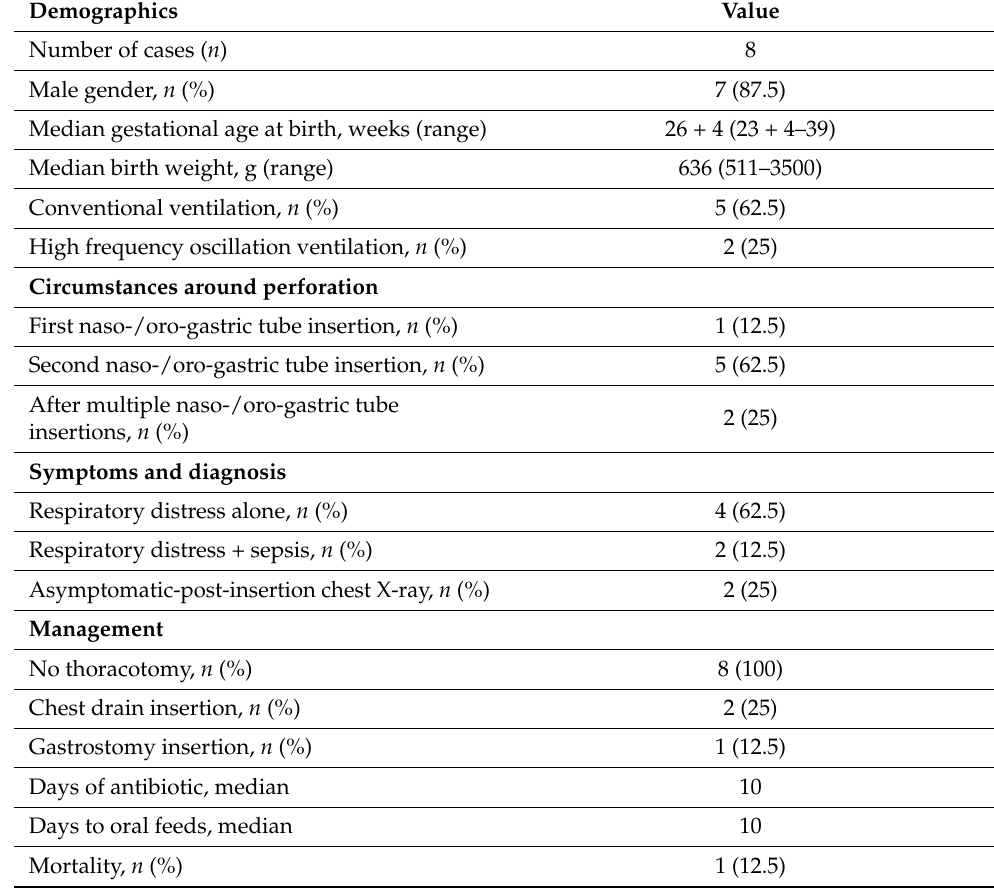
Table 1. Summary of patient demographics and